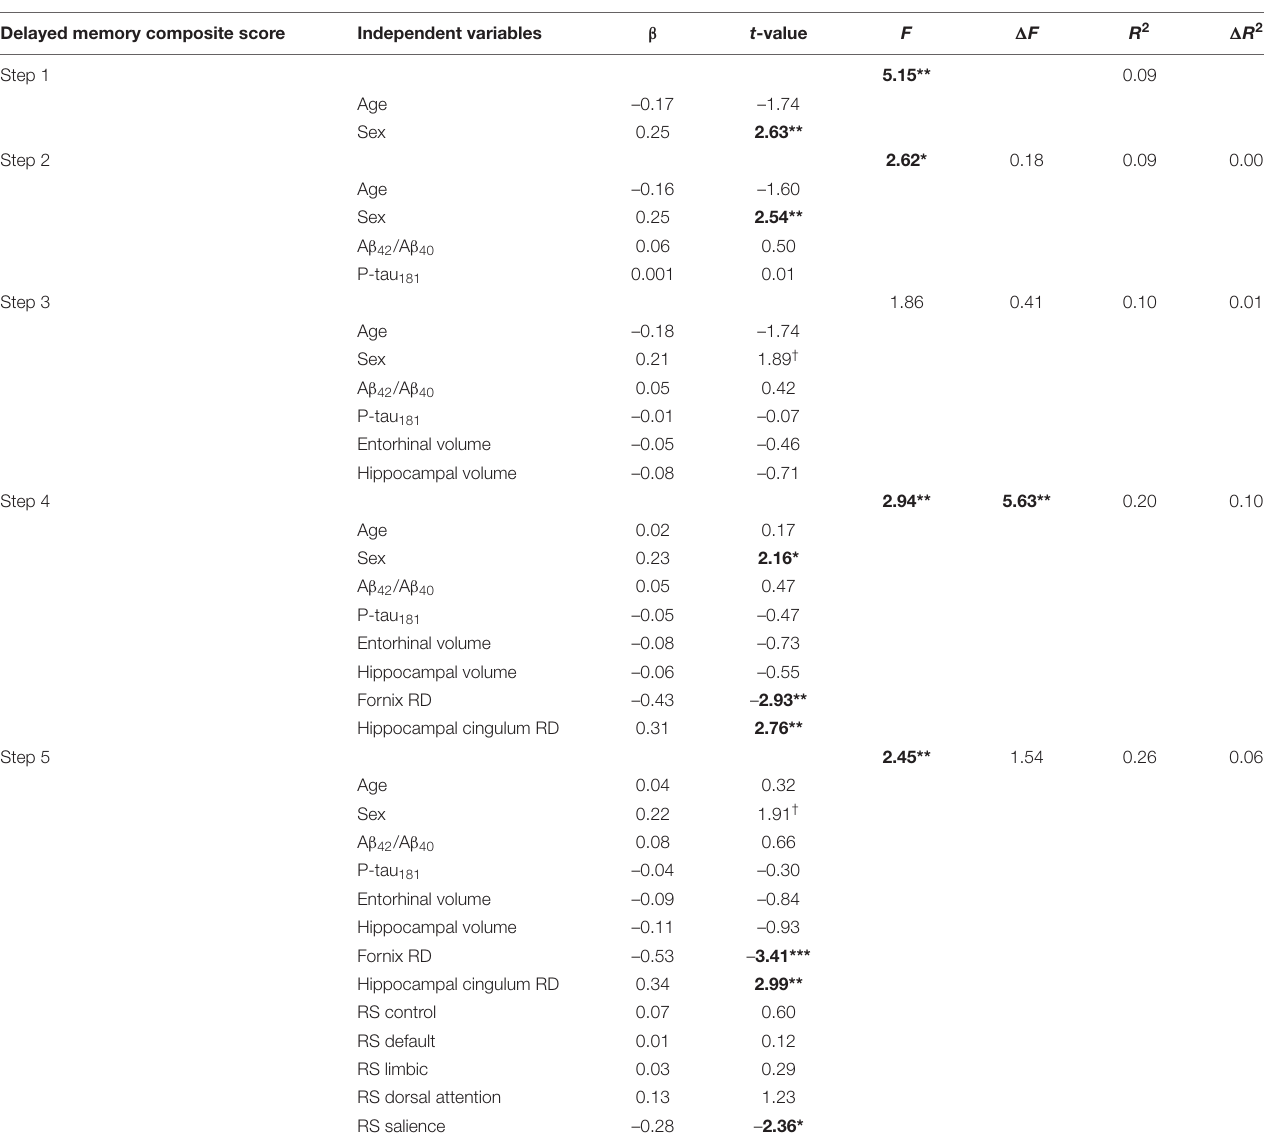
TABLE 2 | Hierarchical regression explaining variability in delayed episodic memory composite. Delayed memory composite